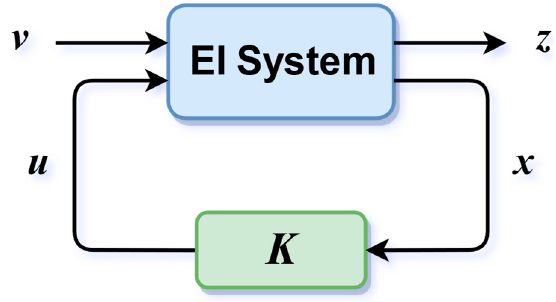
Figure 2. Generalized H ∞ control configuration for EI systems.